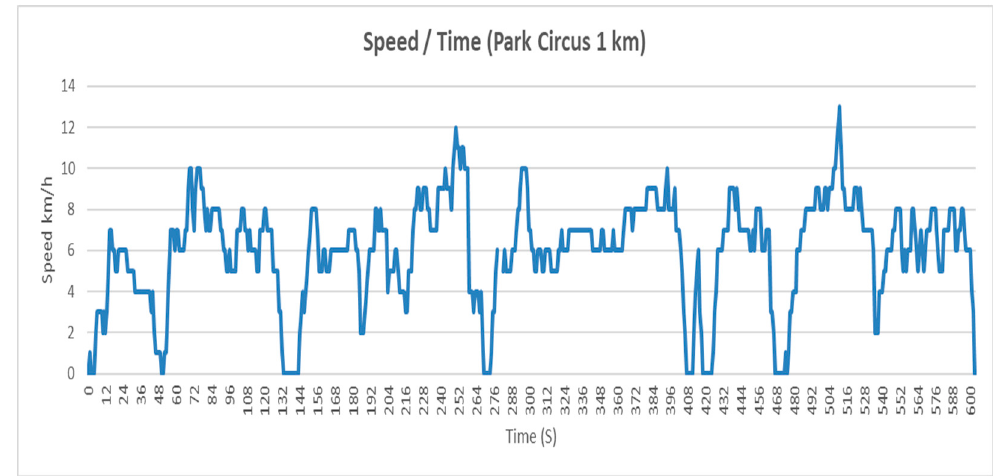
Figure 5. Park Circus speed / time graph. Figure 5 . Park Circus speed/time graph. Figure 5 . Park Circus speed/time graph.